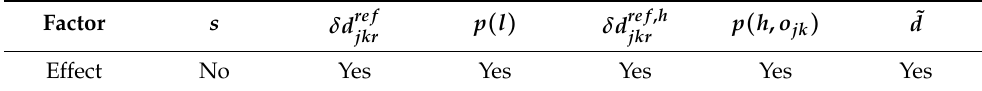
Table 5. Factors impact on time